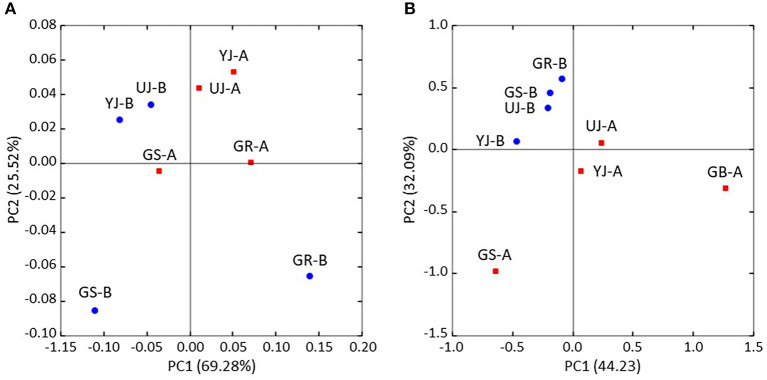
Principal coordinate analysis (PCoA) of (A) bacterial and (B) fungi communities in gochujang samples based on the weighted UniFrac metrics. Blue and red symbols represent samples before and after fermentation, respectively.